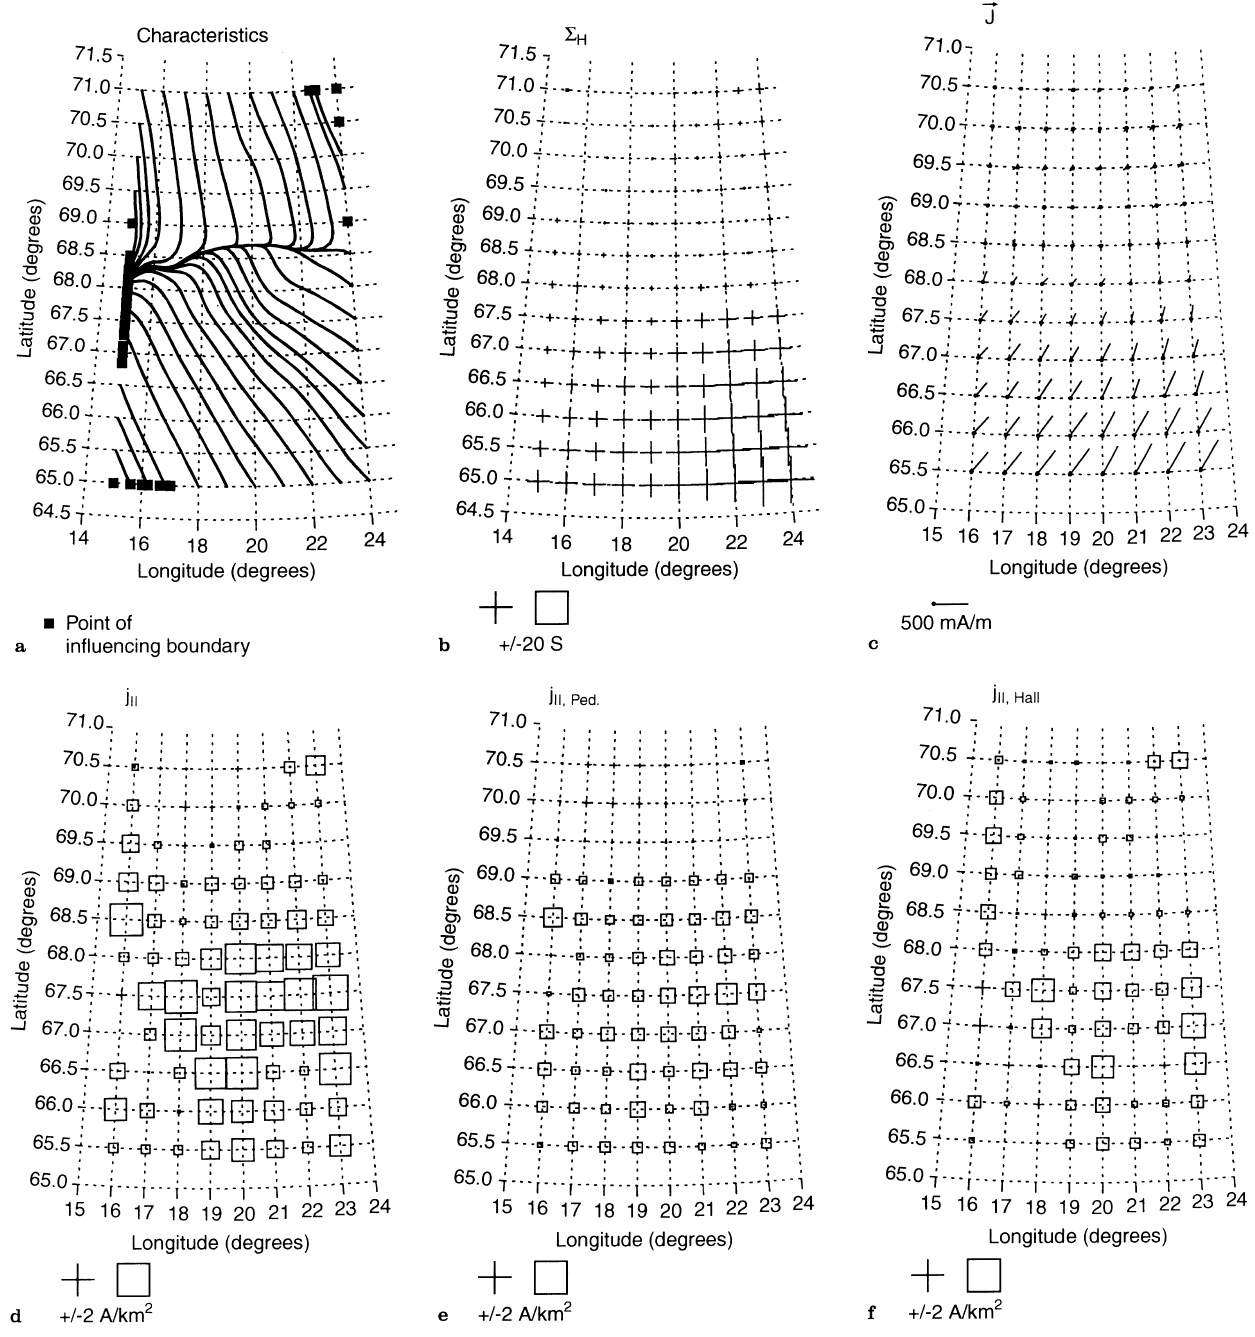
currents connected with Pedersen currents. f Field-aligned currents connected with Hall currents. Crosses mark downward, squares upward